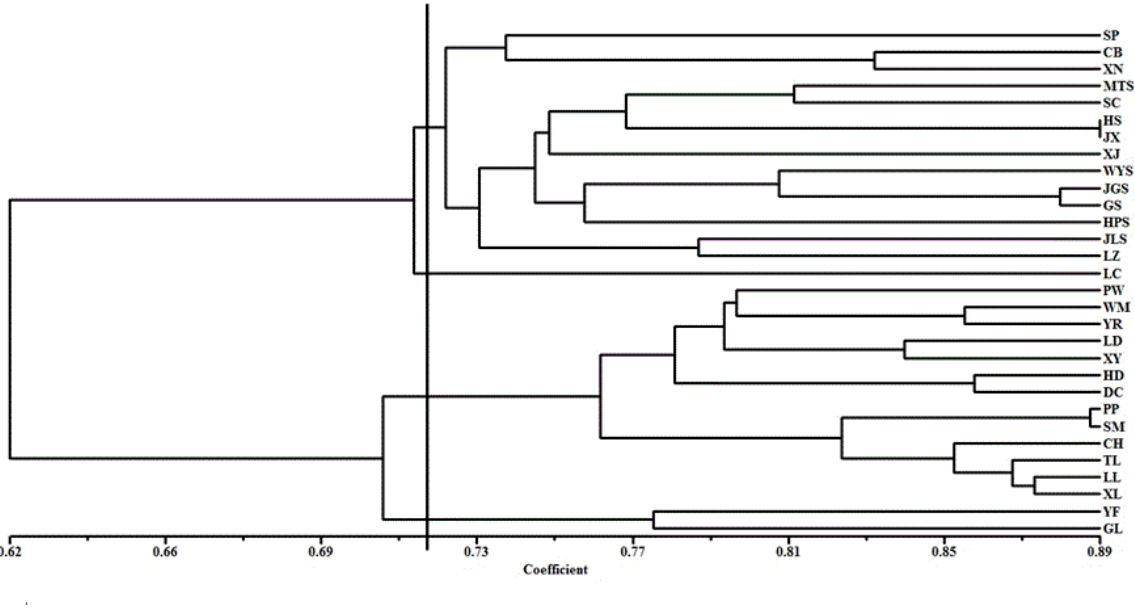
Figure 1. Phylogenetic dendrogram based on the genetic distance by the UPGMA cluster in the 30 populations of T. ciliata